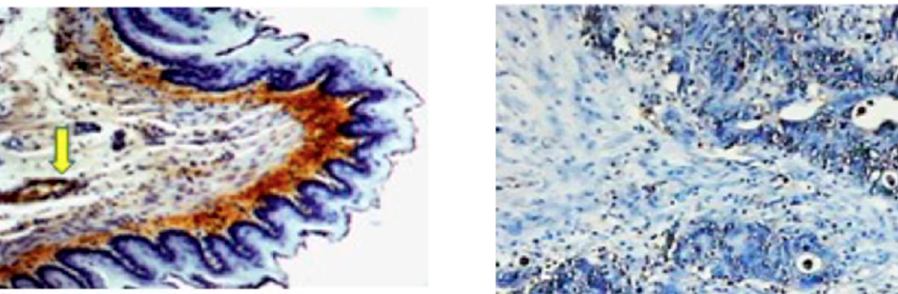
Figure 2. Immunohistochemistry with the monoclonal antibody specific for the 4-HNE–His shows the prominent presence of the protein adducts of the aldehyde in connective tissue (brown) below the 4-HNE–His negative epithelium (blue) of esophagus of a healthy rat ( left photo 100 × ) and in the blood vessel (indicated by the yellow arrow). In human colon cancer, 4-HNE can be seen only in the nuclear region of a few cancer cells ( right photo 50×). In both cases the presence of 4-HNE–protein adducts is visualized by dark brown di-amino-benzidine staining, with the blue hematoxylin contrast staining.